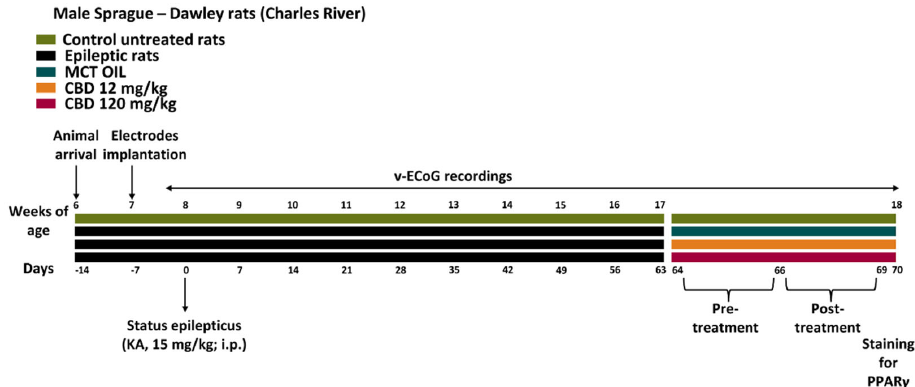
Figure 1. Experimental design. Thirty ‐ eight male Sprague ‐ Dawley rats were purchased at 6 weeks of age, and cortical electrodes were implanted 1 week later for video ‐ electrocorticographic (v ‐ ECoG) recordings of recurrent seizures. Status epilepticus (SE) was induced with an intraperitoneal (i.p.) administration of kainic acid (KA; 15 mg/Kg) at 8 weeks of age (n = 2 rats died during the SE). Ten epileptic rats per group were treated with cannabidiol (CBD) at 12 mg/kg, 120 mg/kg, or with me ‐ dium ‐ chain triglyceride (MCT) oil. The remaining animals (n = 6) were used as control, non ‐ treated rats.